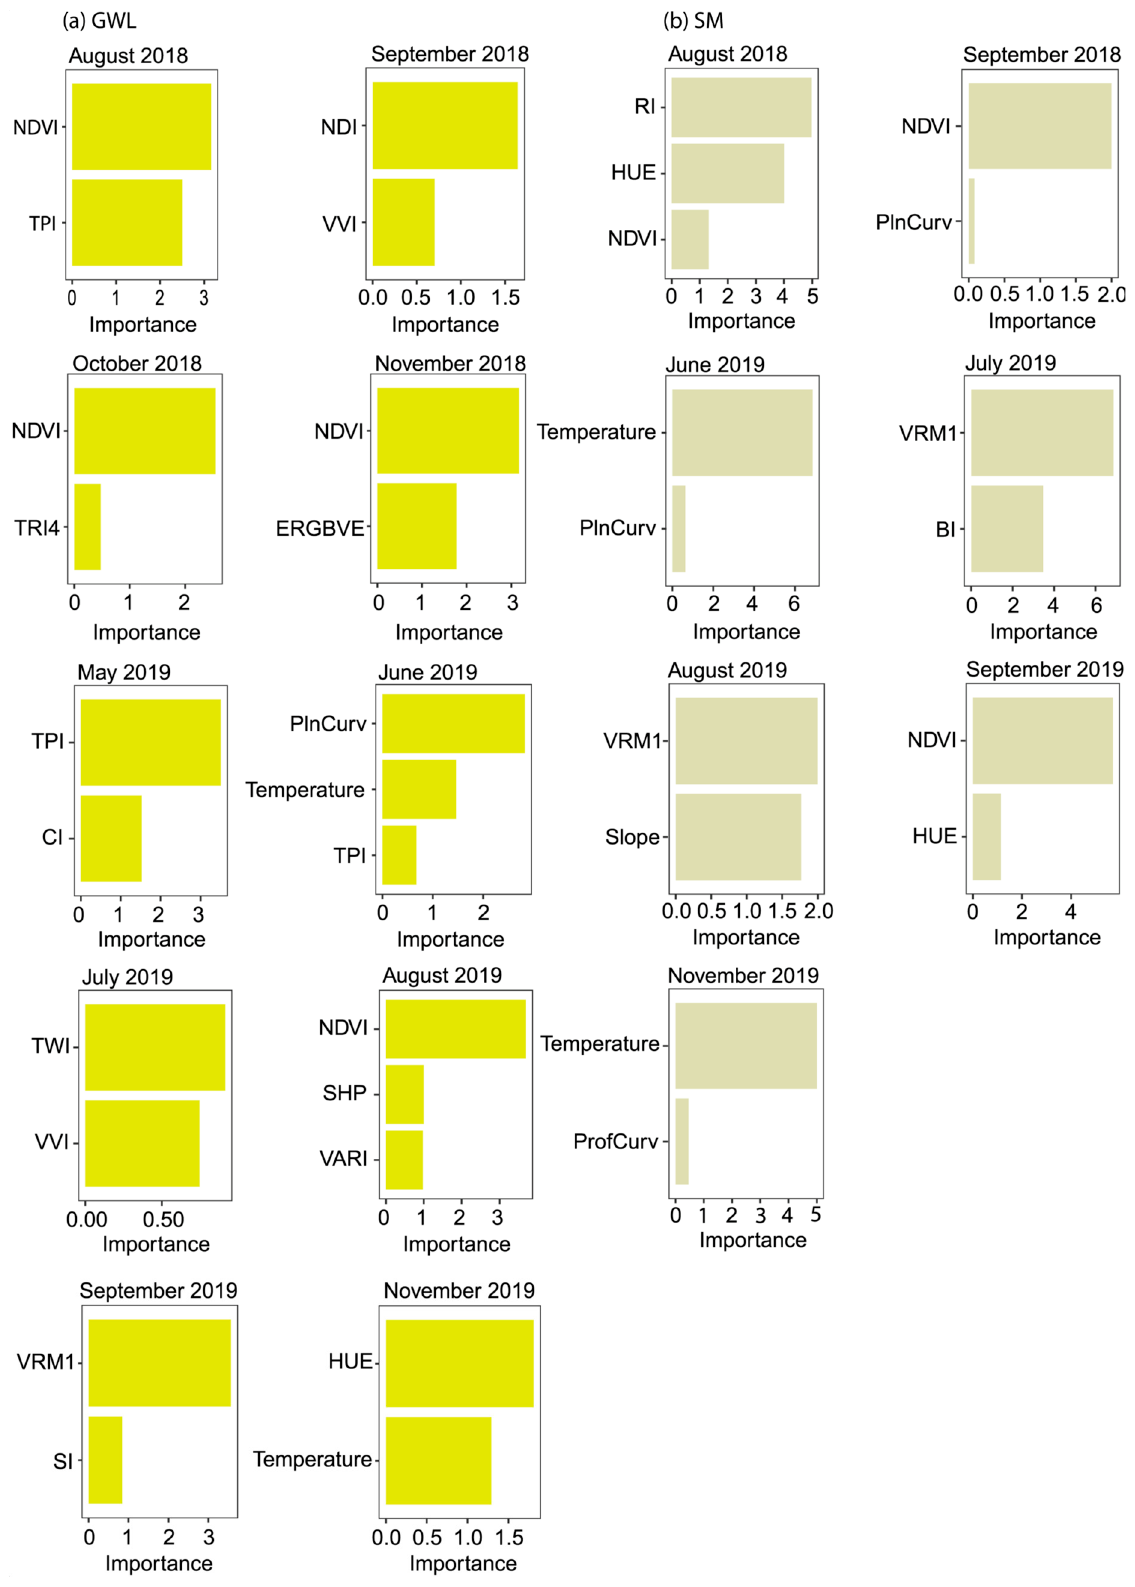
Figure 9. Importance of predictor variables within the Random Forest model based on the FFS distributed variables for ( a ) GWL and ( b ) SM at the LP. Importance is shown as the increase of the mean squared error.